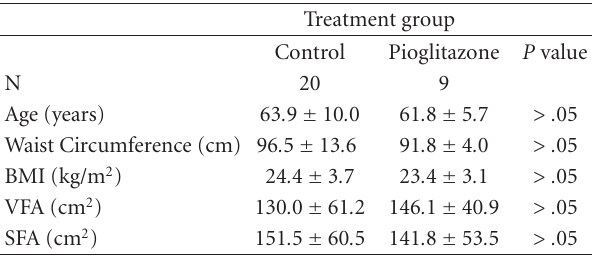
Table 1: Clinical characteristics of study participants. Treatment